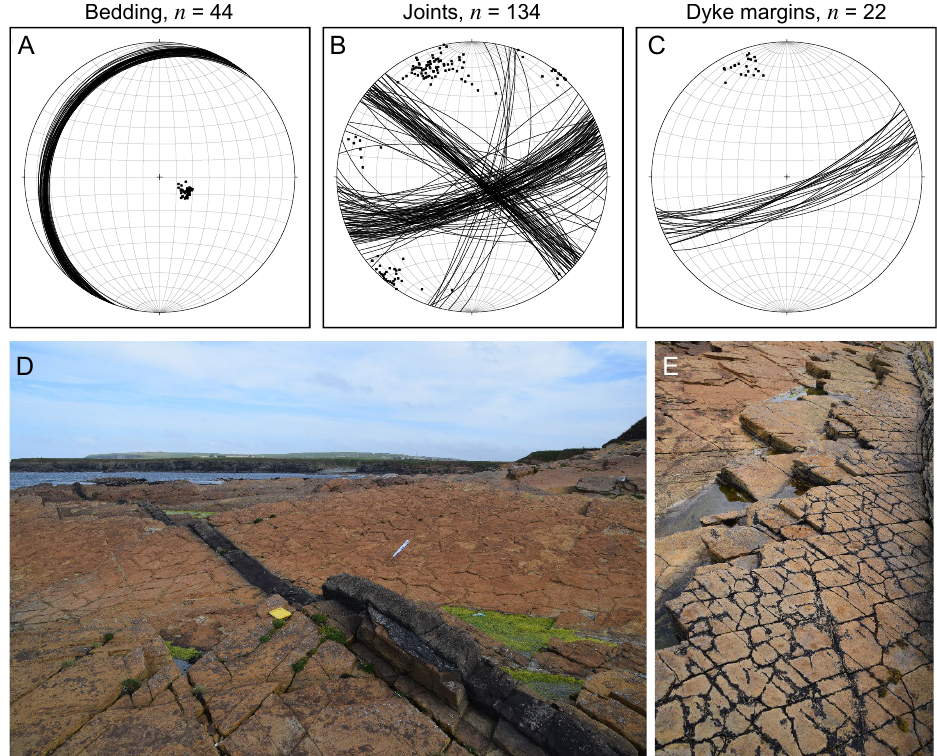
Figure 4: Orientation data from Birsay. Stereograms plotted as equal area, lower hemisphere projections, with great circles and poles. [A] The orientation of bedding is very uniform over the whole mapped area, with an average strike of approximately 030 and dipping approximately 20° to the WNW. [B] Three prominent sets of joints are developed throughout the area, with two main sets oriented ENE/WSW and NW/SE, and a less well- developed set trending NNE. [C] Dyke margins (away from the segment tips) are also very uniform and follow the trend of one of the joint sets ENE/WSW, dipping steeply (70–80°) to the